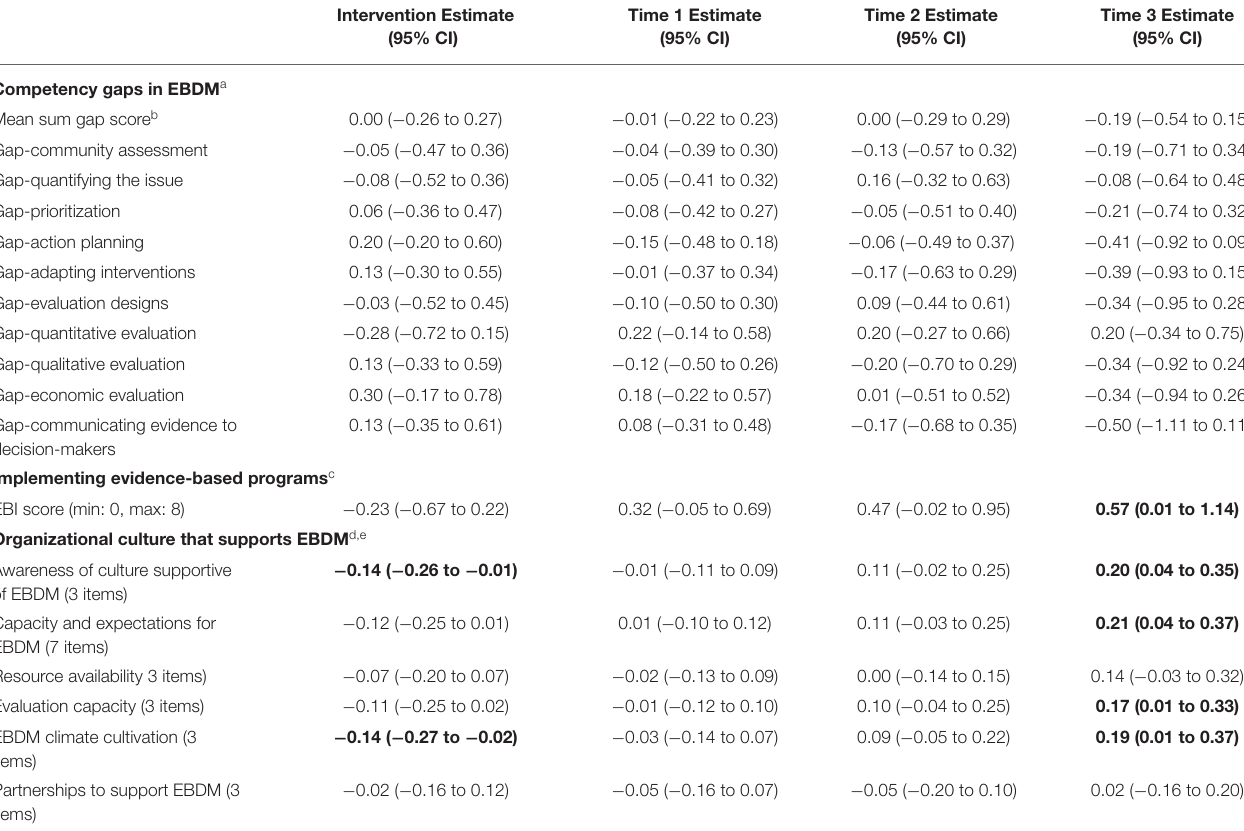
TABLE 4 | Intervention effect estimates for